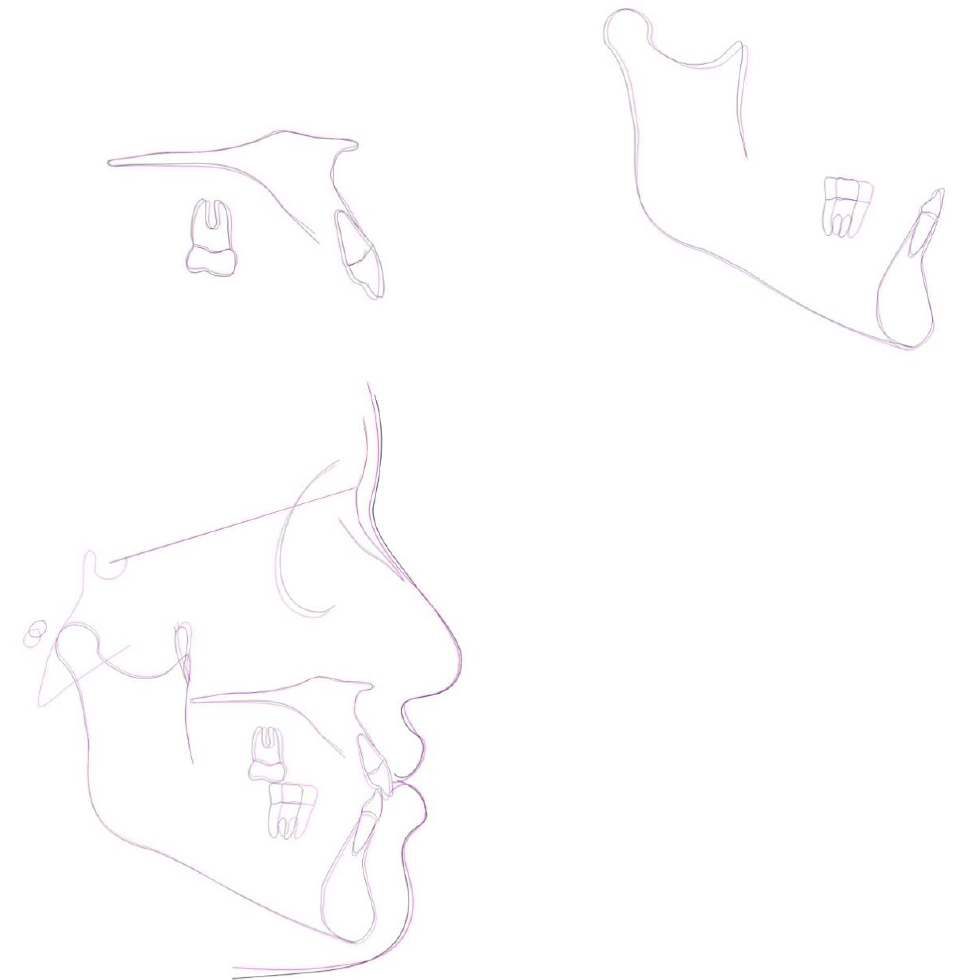
Figure 9. Superimposition of cephalometric tracings before treatment (black) and at the end of treatment (pink).